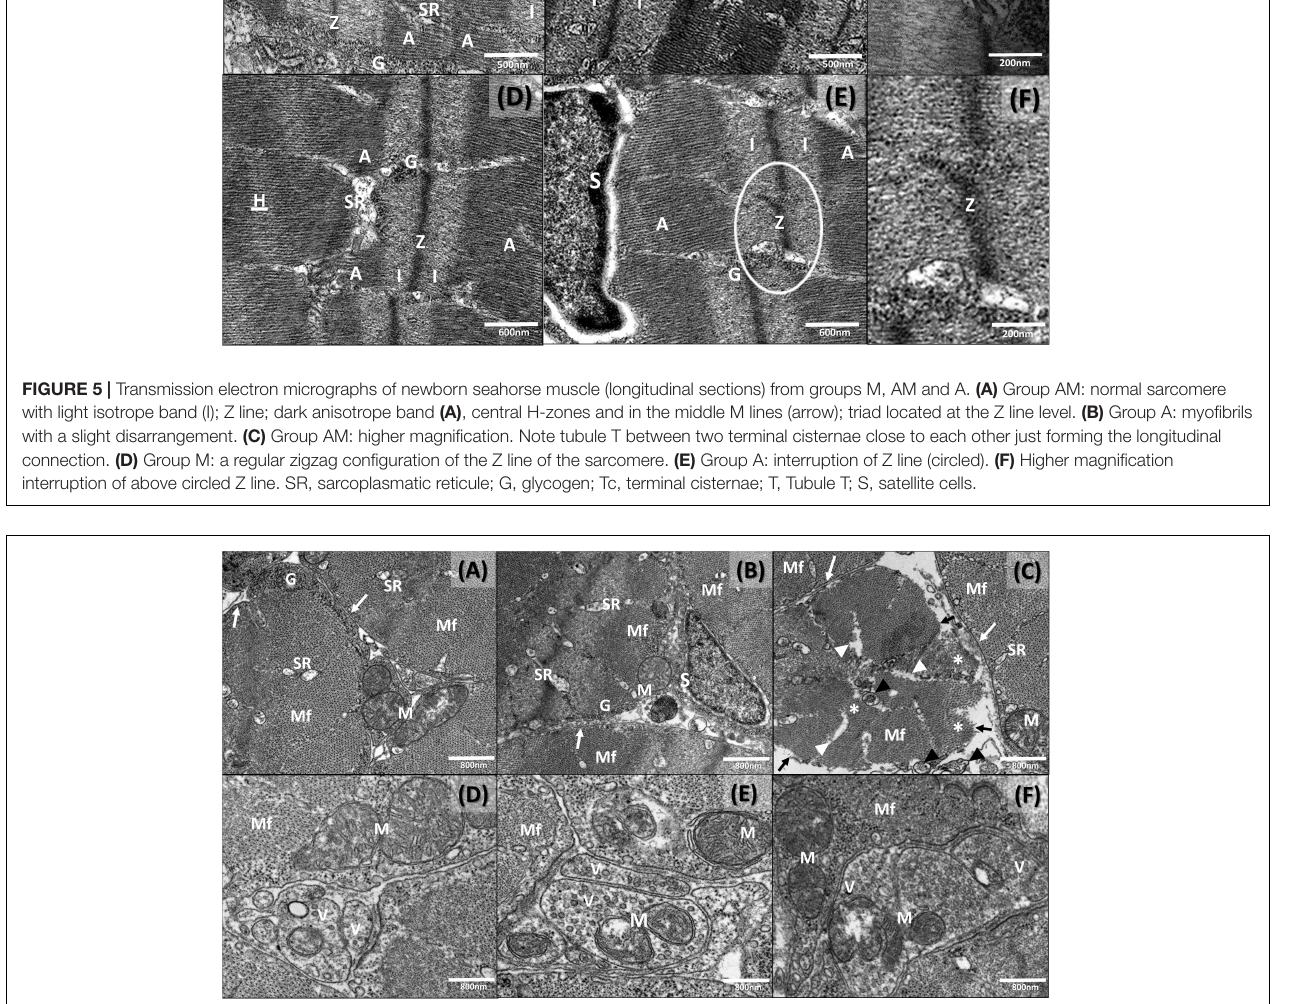
FIGURE 6 | Transmission electron micrographs of newborn seahorse muscle (cross sections) from groups AM, M, and A. (A) Group AM: normal structure. (B) Group M: normal structure. (C) Group A: disarrangement of myofibrils (asterisks); myofibrillary interstitial spaces (white arrow heads); discontinuity of the sarcolemma (black arrows); myelin-like bodies (black arrow heads). (D) Group AM: nerve ending. (E) Group M: nerve ending. (F) Group A: nerve ending. S, satellite cells; SR, sarcoplasmic reticule; Sarcolemma (white arrows); Mf, myofibrils; M, mitochondria; G, glycogen; V,